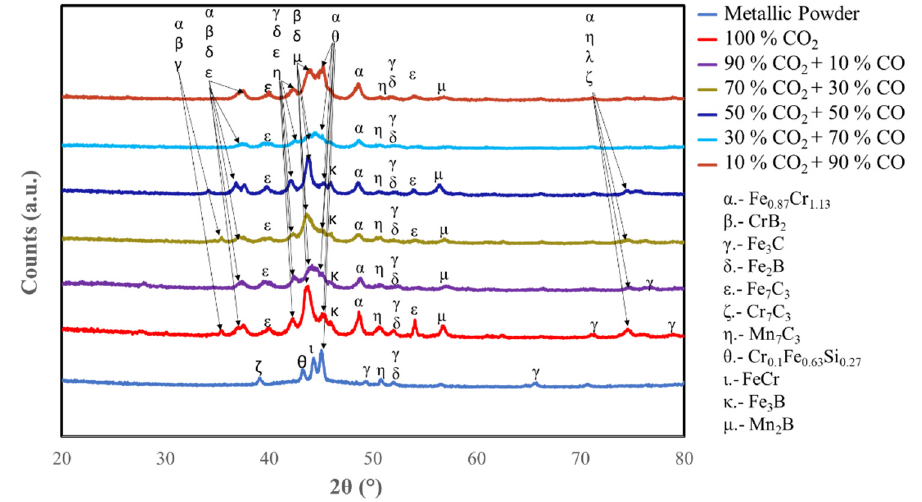
Figure 2. XRD of the metallic powder as received and the hardfacing sintering in an oven with six different atmospheres.